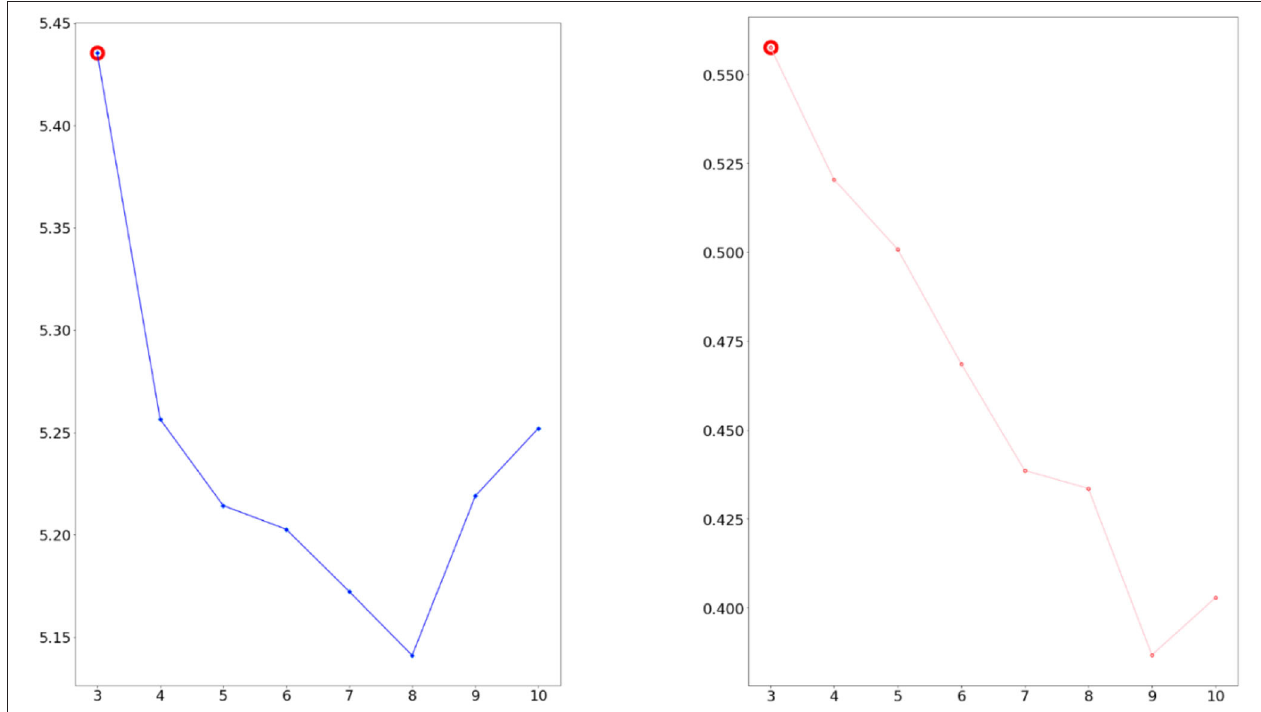
FIGURE 4 | Calculated perplexity (left) and C V (right) for selecting optimal number (2007–2009 dataset).